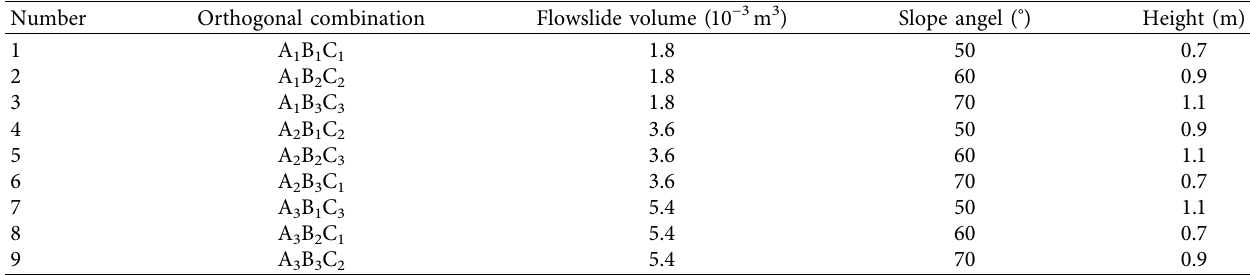
Table 1: Orthogonal experimental